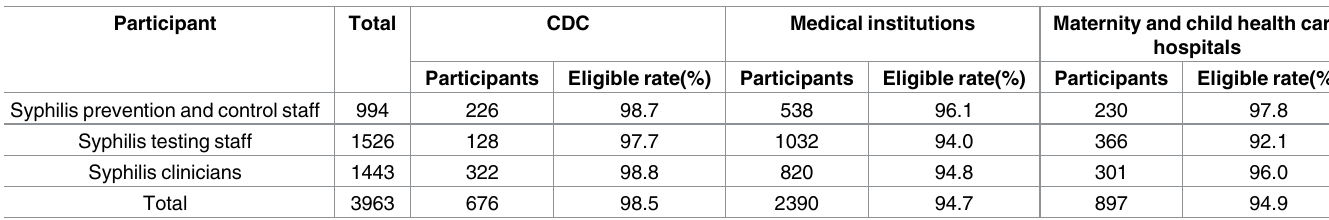
Table 1. Awarenessof syphilis prevention and treatment knowledge among professional personnel in Jiangsu, China, 2015 (n = 3963). Participant Total